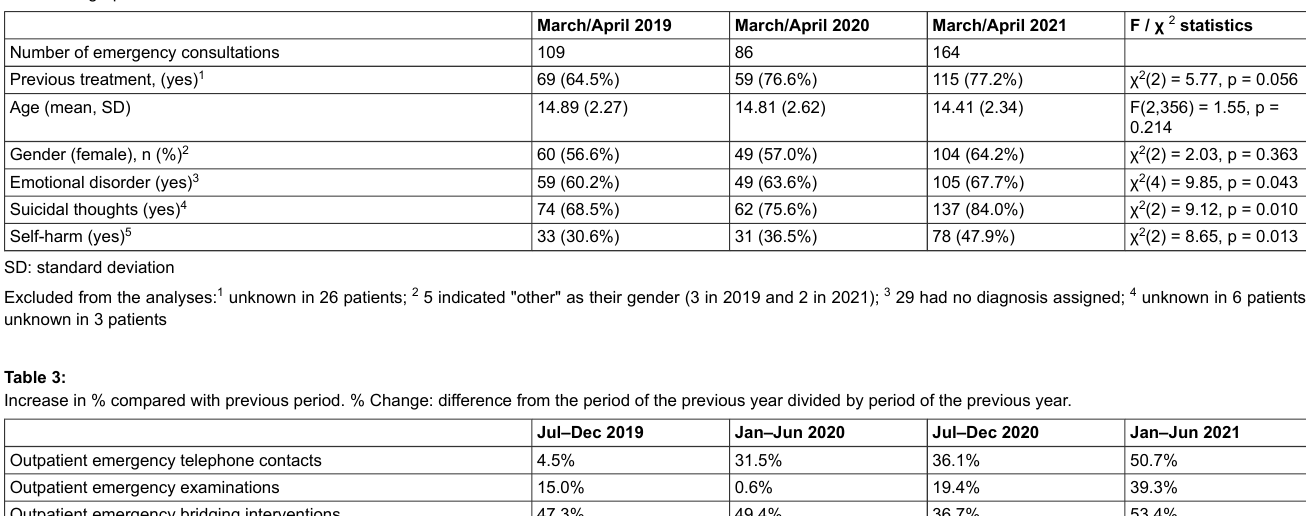
Table 2: Sociodemographic and clinical characteristics.